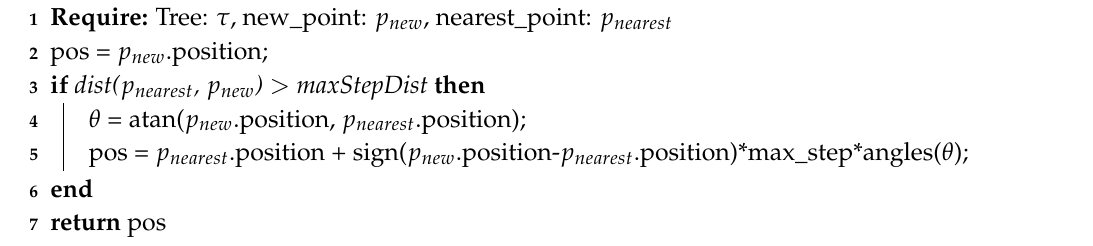
Algorithm 5: Rapidly-Exploring Random Trees (RRT) steering function.